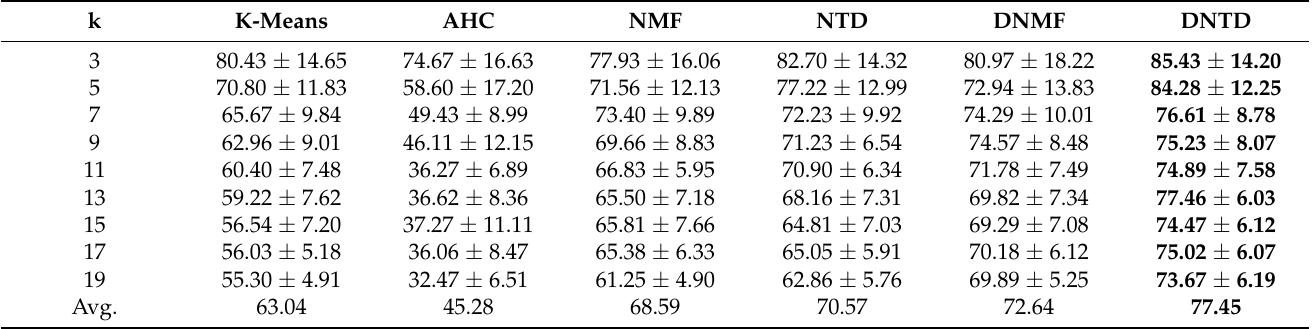
Table 1. AC (%) ± standard deviation (%) of different algorithms on ORL dataset.